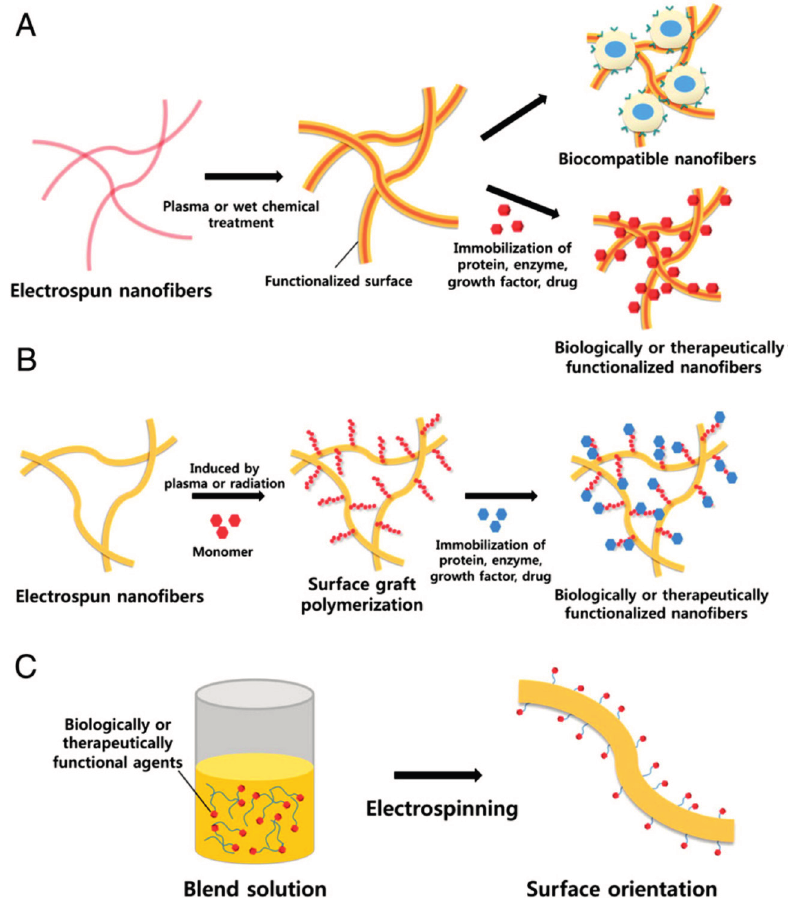
Figure 6. Different modification techniques using ( A ) plasma treatment ( B ) surface graft polymerization ( C ) Co-electrospinning. Reprinted with permission from [72]. Copyright © 2009 Elsevier